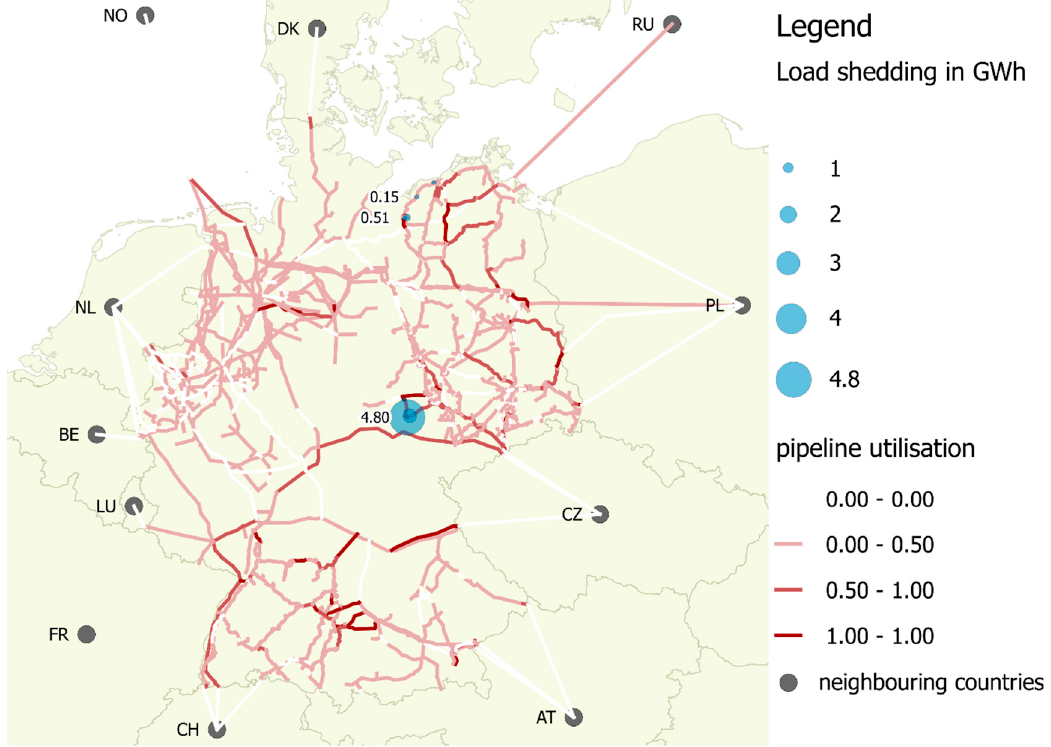
Figure 10. Results of GAMAMOD-DE on simulated German load shedding regions in 2012.